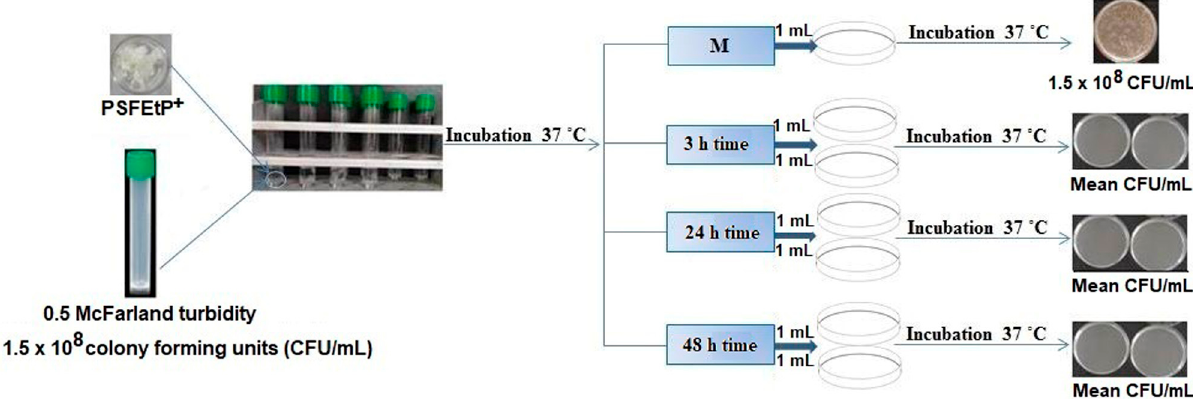
Figure 2. Work diagram: Stages of the experimental